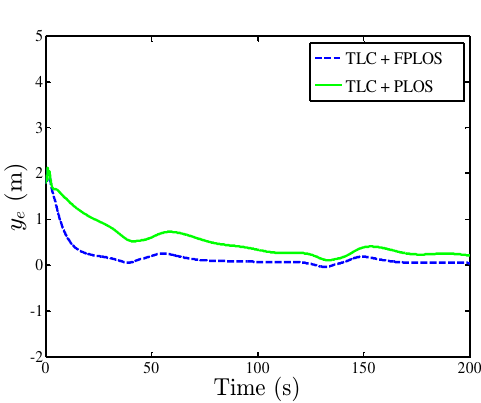
Figure 9. Along-track errors x e .